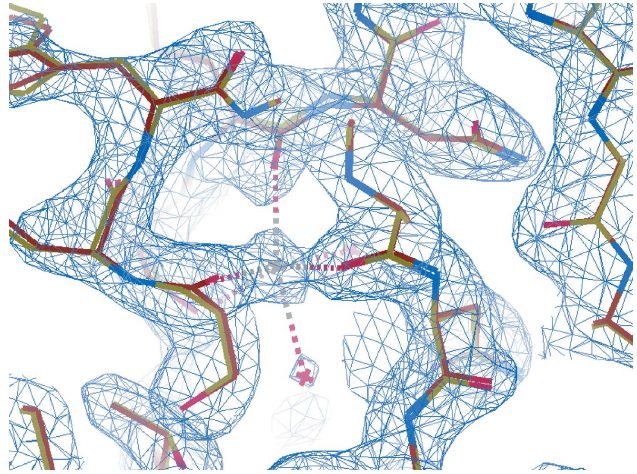
Figure 9 The 2 F o (cid:3) F c electron-density map (blue) contoured around the sodium- ion binding pocket, where F o represents the observed structure-factor magnitudes, and both F c and the phases were calculated from the initial model for phasing (PDB entry 4zix). Also shown is the alignment of our structure solution (yellow) and the structure of 5uvj (red) solved by Martin-Garcia et al. (2017). Small deviations are seen more clearly between the structures near the solvent-exposed regions in the yellow and red representations. Waters are seen as red crosses, the sodium ion as a gray cross, and the residues coordinating the sodium atom (Ser60, Cys64, Arg71 and Ser72) as red dashes. The oxygen atoms (in red) seen near the top of the figure have the largest displacement of 0.13 A˚ among all the atoms